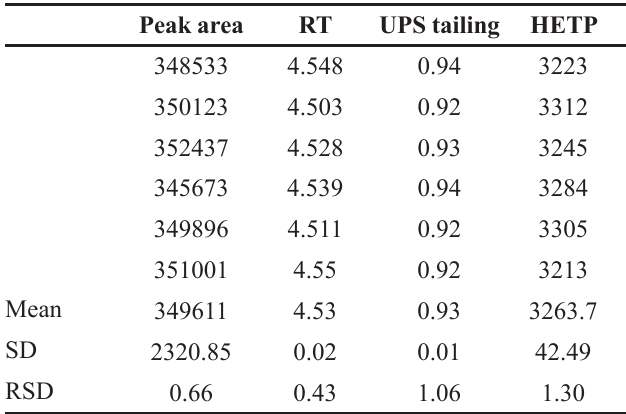
TABLE I - System suitability (n=6)